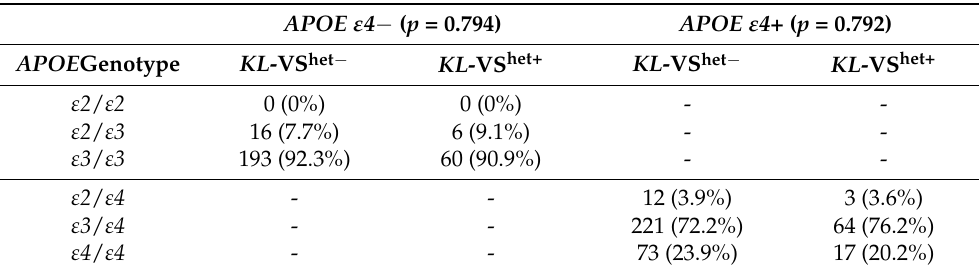
Table 2. Total and relative, in parentheses, frequencies of particular APOE genotypes in groups defined by KL- VS het and APOE ε 4 -carrier